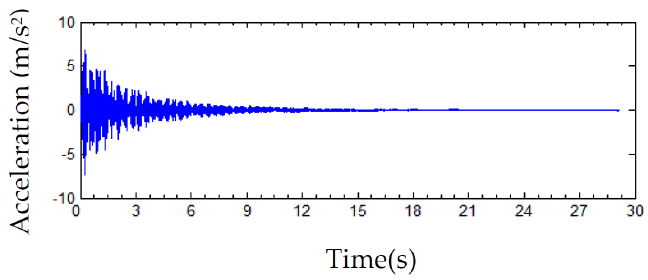
Figure 8. Acceleration responses of Node 9 for GK9.